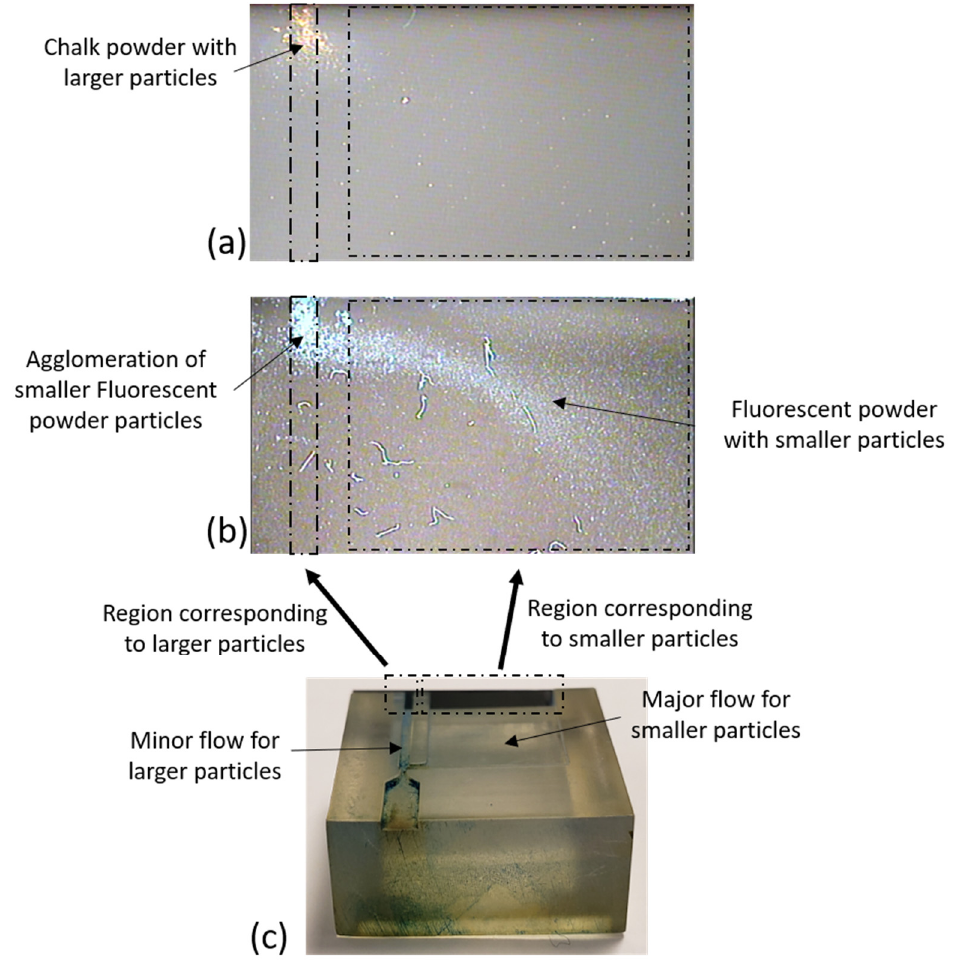
Figure 12. ( a ) Chalk powder particles collected in the region corresponding to the larger particles. ( b ) fluorescent powder collected in the region corresponding to the smaller particles. ( c ) Silicon sample fitted at the end of the flow channels marked with regions corresponding to the minor and the major flows.